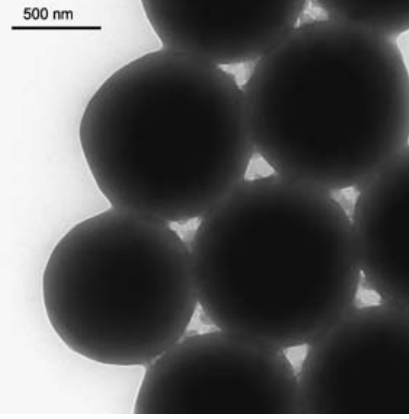
Figure 5. Representation of reversible hydrophilic and hydrophobic nature of the polymer particles grafted with PNIPAAM brushes.